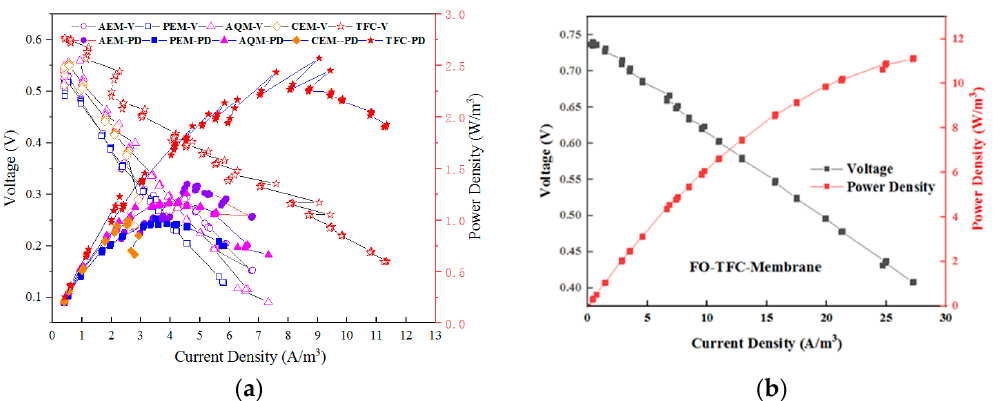
Figure 5. ( a ) Polarization curves and power density curves of the different partition materials; ( b ) changes in polarization curves after increasing the concentration of the draw solution/catholyte.